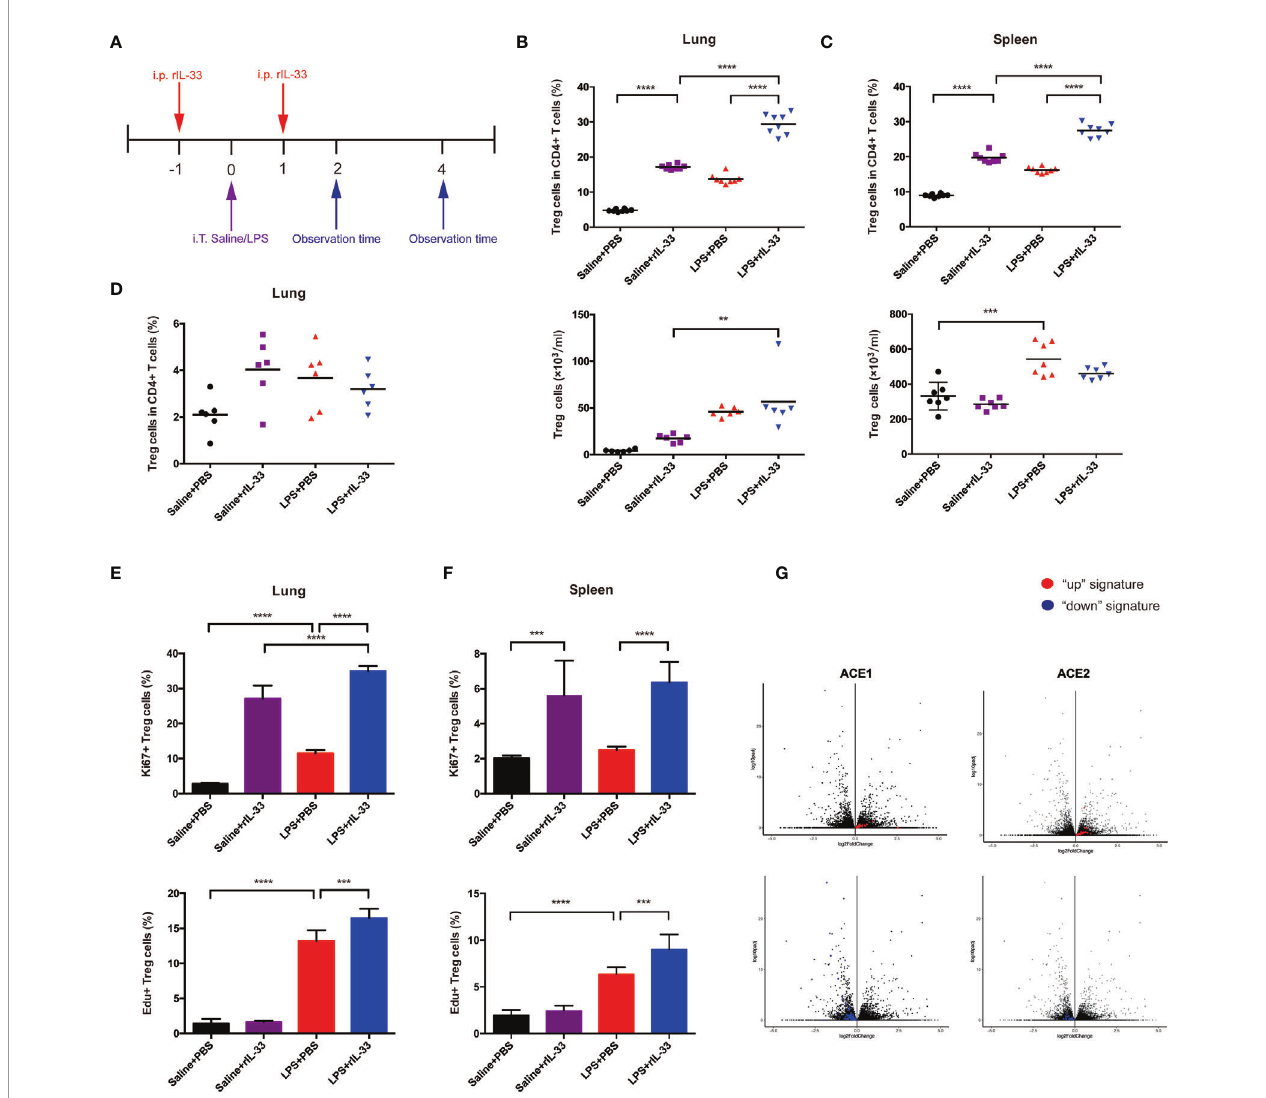
FIGURE 7 | IL-33 activates the Treg cell population in LPS-induced acute respiratory distress syndrome and promotes pulmonary repair. (A) Schematic diagram of the protocol for IL-33 supplementation. BALB/c mice were injected with rIL-33, and 1 day later, intratracheal administration of saline/LPS was performed. rIL-33 was repeatedly i.p. injected after 1 day, and the mice were sacri fi ced and observed at 2 days or 4 days after LPS/saline treatment. (B, C) Expansion of the Treg cell population in IL-33-treated mice. BALB/c mice were intratracheally injected with saline or LPS supplemented with rIL-33 in PBS or PBS the day before and after lung injury and were detected 4 days later. (B) Expansion fraction and numbers of Treg cells in lungs. (C) Expansion fraction and numbers of Treg cell populations in the spleen. (D) Expansion of pulmonary Treg cells does not depend on the circulating pool in IL-33-treated mice. Mice were treated with FTY720 or PBS a day prior to LPS-induced lung injury and daily thereafter, and the Treg cells in the lung suspension were measured by fl ow cytometry 2 days after LPS administration. (E, F) Augmentation of Treg cell proliferation in IL-33-treated mice. (E) Proliferation of Treg cells in the lung and (F) spleen was analyzed via Ki67+ or EdU+ Treg cells by fl ow cytometry 2 days after saline/LPS administration in addition to IL-33. (G) RNA-seq analysis of lung AEC1 or AEC2 regeneration in IL-33-treated mice in the LPS+rIL-33 group vs LPS+PBS group at 4 days. The left upper panel displays the AEC1 “ up ” signature, and the left lower panel shows the AEC1 “ down ” signature. The right upper panel displays the AEC2 “ up ” signature, and the right lower panel shows the AEC2 “ down ” signature. n = 4 mice per group. For all panels: mean ± S.D. **p ≤ 0.01; ***p ≤ 0.001; and ****p ≤ 0.0001 for one-way analysis of variance with the Bonferroni post hoc test for multiple t-tests. A value of p < 0.05 was considered statistically signi fi